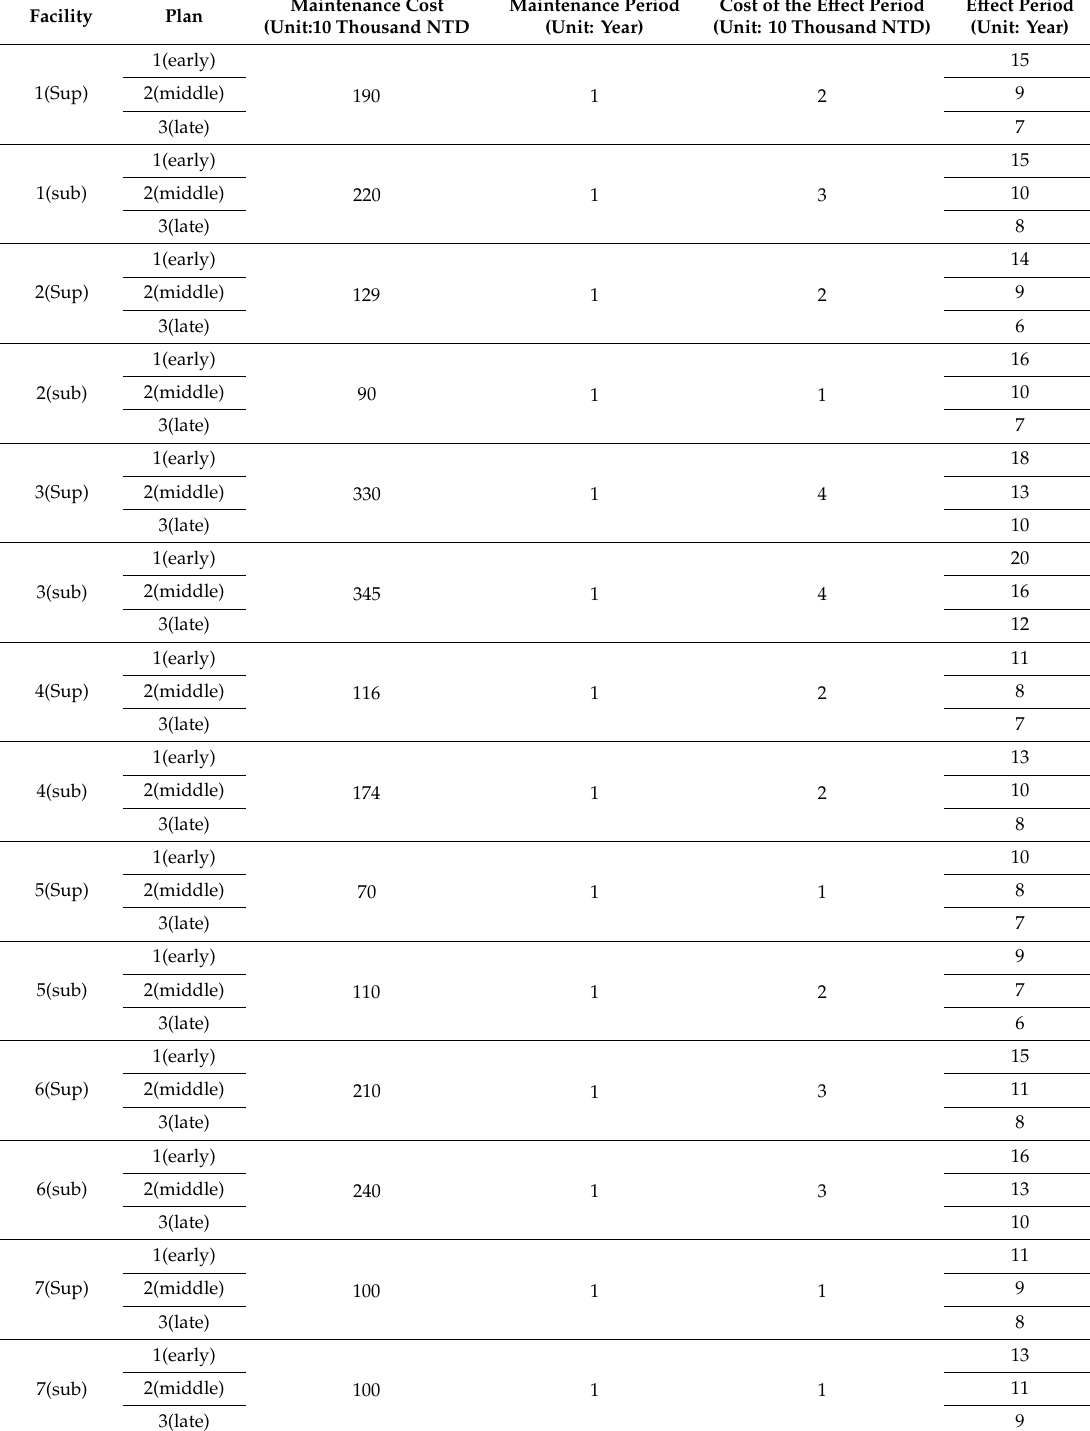
Table 7. Maintenance plan of case